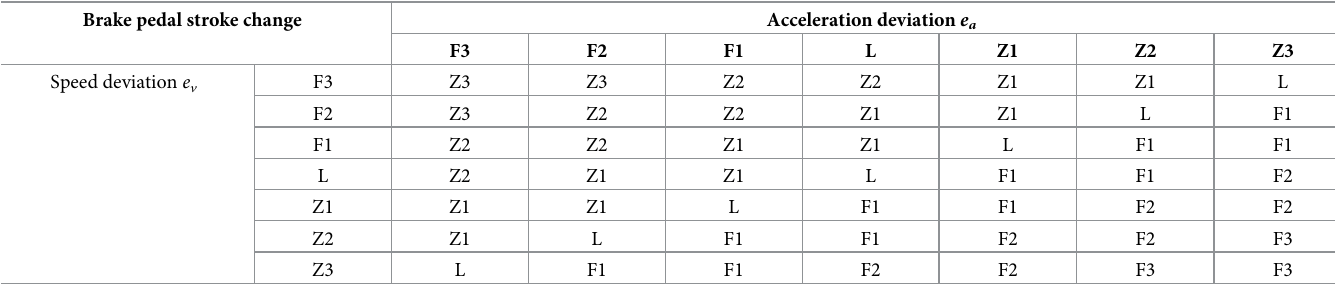
Table 1. Fuzzy control